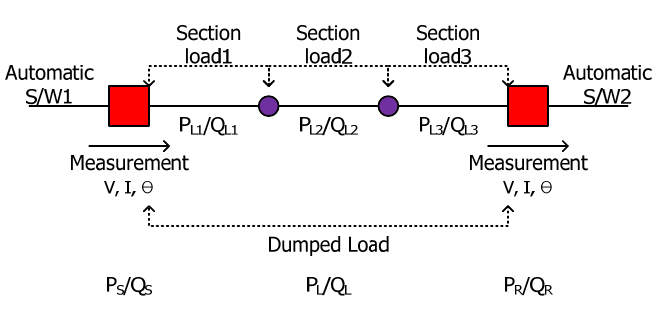
Figure 5. Concept of section